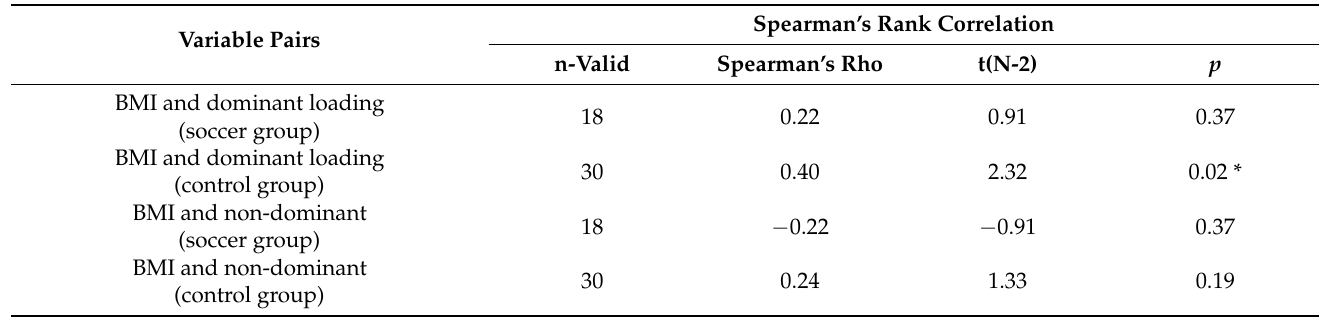
Table 7. Spearman’s rank correlation coefficients of BMI (body mass index) and load in the dominant and non-dominant limbs in the dynamic test in both study